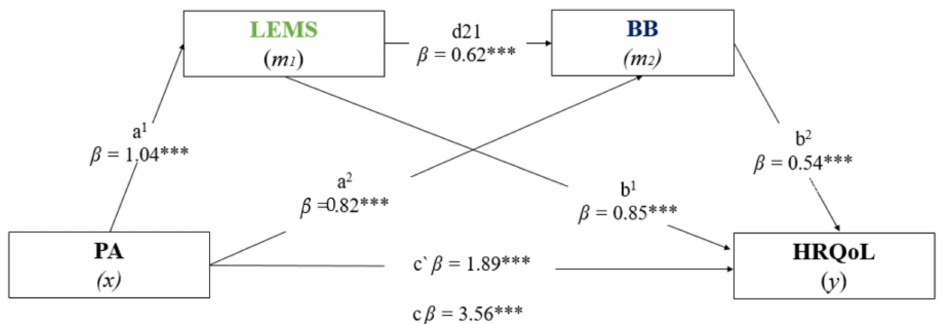
Figure 1. Analysis of parallel mediation of the effects of PA (physical activity) on HRQoL (health-related quality of life) through LEMS (lower extremity muscle strength) and BB (body balance). The analysis was based on 5000 bootstrap samples. The indirect effect was statistically significant at the 95% confidence interval (CI) when the CI did not include 0. Betas ( β ) were reported as the product of simultaneous regression with bootstrap replacement: (1) Path a 1 and a 2 = association between PA with LEMS and BB, respectively, (2) Path d21 = association between both mediations variable ( m 1 and m 2 ), (3) Path b 1 and b 2 = association between LEMS and BB with HRQoL, (4) Path c, = direct effect ( x – y ): associations m 1 green and m 2 blue = indirect effect ( x – y ) by LEMS and BB, respectively. *** p < 0.001, c = total effect; c’ = direct effect; a = path Model 1; b = path Model 2.